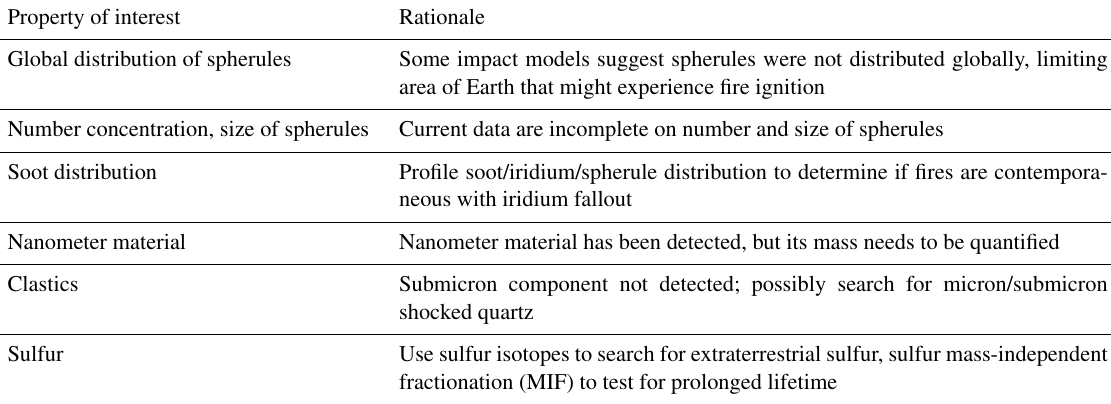
Table 7. Suggestions for data